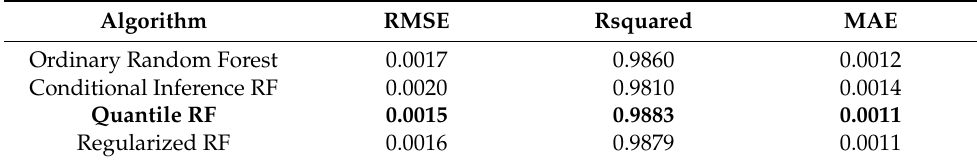
Table 10. Summary of random forests trained.